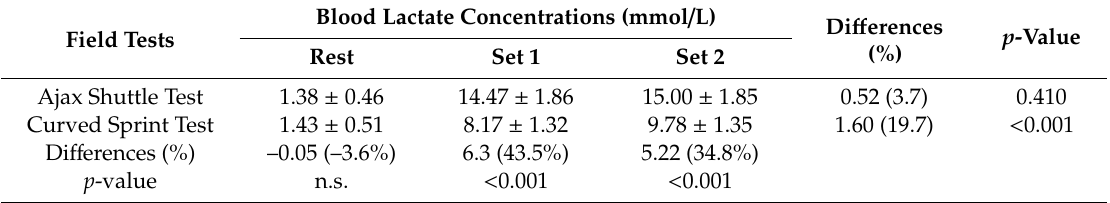
Table 4. Blood lactate concentrations (mmol / L) at rest and after * AST and